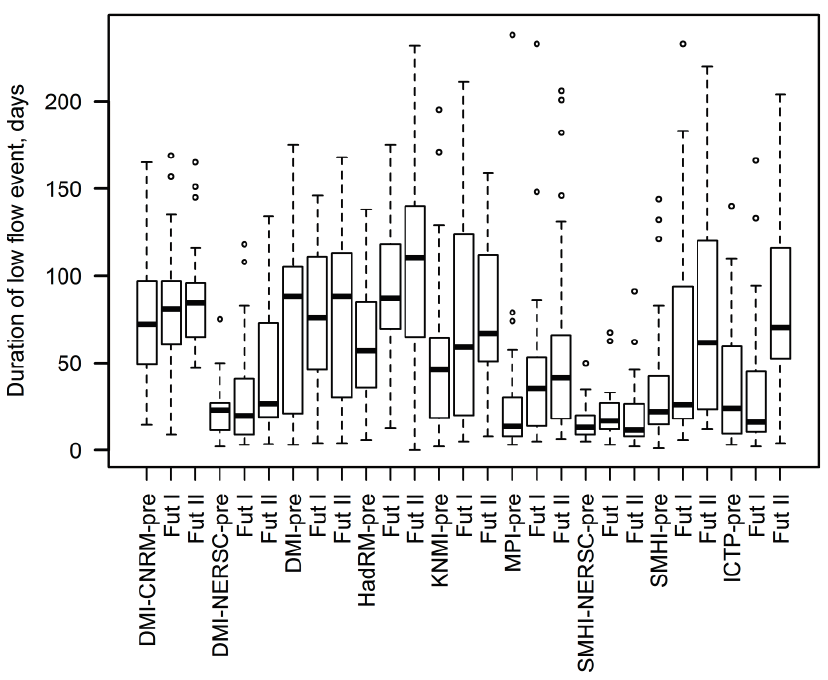
Figure 8. Duration of low flow event in days for reference and two future periods for all nine future projections,